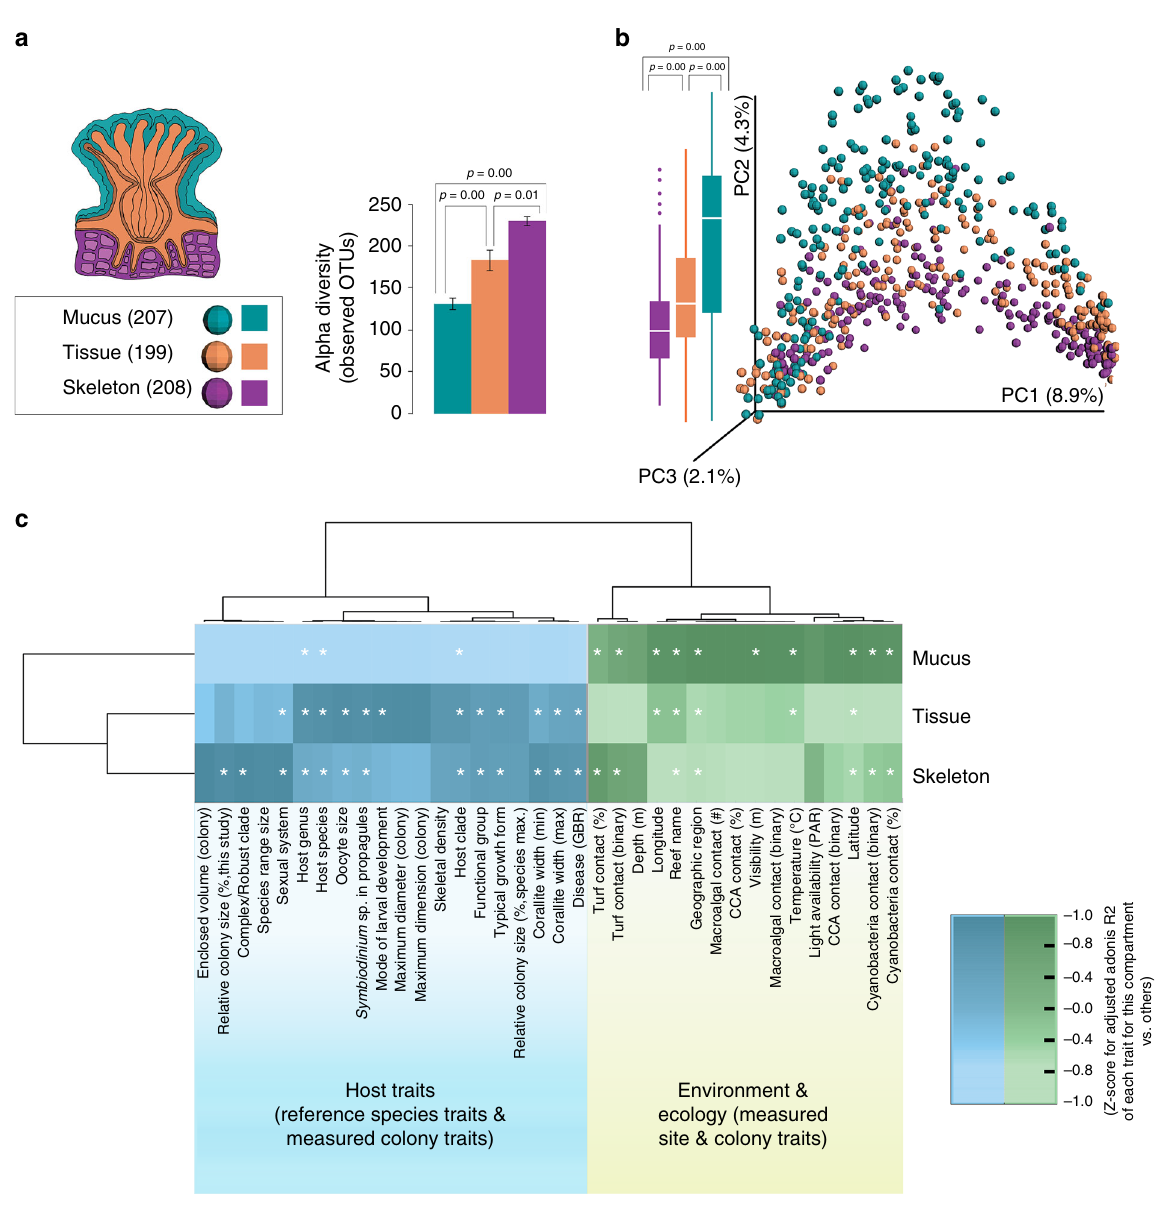
Fig. 1 Anatomical differences in coral microbiomes. Coral mucus, tissue, and skeleton microbiomes differ in richness, composition, and response to host vs. environmental factors based on 16S rRNA gene sequence data. a Microbial community richness (observed OTUs) in coral mucus (teal), tissue (orange) and skeleton (purple), assessed at an even depth of 1000 reads per sample. P -values re fl ect Tukey ’ s HSD. b Principal coordinates plot of coral-associated microbial communities (Unweighted UniFrac; n = 614). Reads were rare fi ed to 1000 reads per sample. Coral compartments show signi fi cant differences in community composition (Adonis R 2 = 0.028; permutational p < 0.001). The percent variation explained by the principal coordinates is indicated at the axes. Boxplots of the second PC elucidate differences among compartments. P -values re fl ect Tukey ’ s HSD. c Relative in fl uence of host and environmental factors on microbiome composition (Weighted UniFrac, Adonis adjusted R 2 ) in each compartment. Darker cells for a compartment indicate that it is more strongly in fl uenced by that trait than the other compartments (Adonis adjusted R 2 values z -score normalized within columns). Cell values re fl ect adjusted R 2 , which penalizes R 2 for each factor downward to allow for fair comparison among factors with varying degrees of freedom. Asterisks indicate a signi fi cant effect of that factor (Adonis permutational p < 0.05) on the microbiome in that compartment, following stringent Bonferroni correction across all traits and compartments. While both host and environmental factors in fl uenced all compartments, host factors tended to in fl uence coral tissue and skeleton more strongly than mucus, whereas host environment more in fl uenced mucus microbiomes. All values in the table, plus other combinations of rarefaction depth and multivariate dissimilarity measure are presented in Supplementary Data